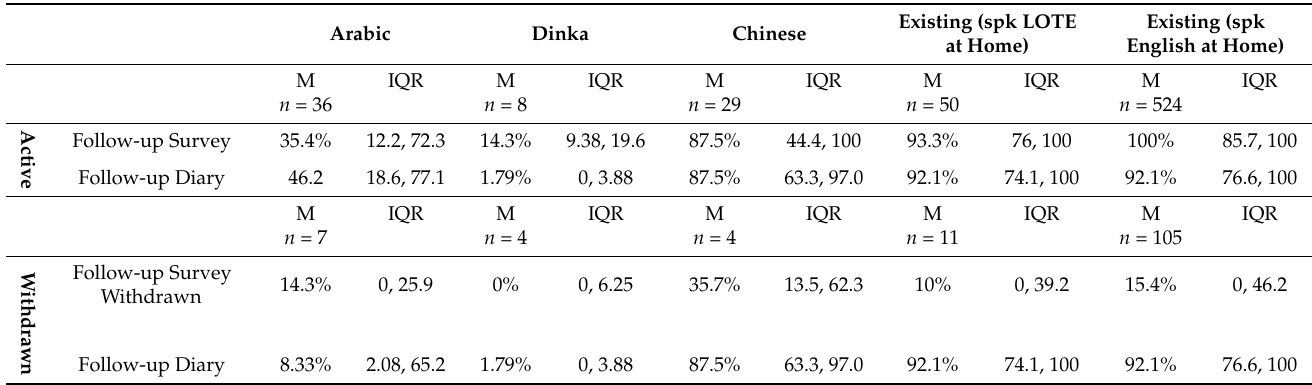
Table 4. Survey and diary completion rates of participants in each language group among those remaining active in the cohort until the end of the study and from those withdrawing before the end of the